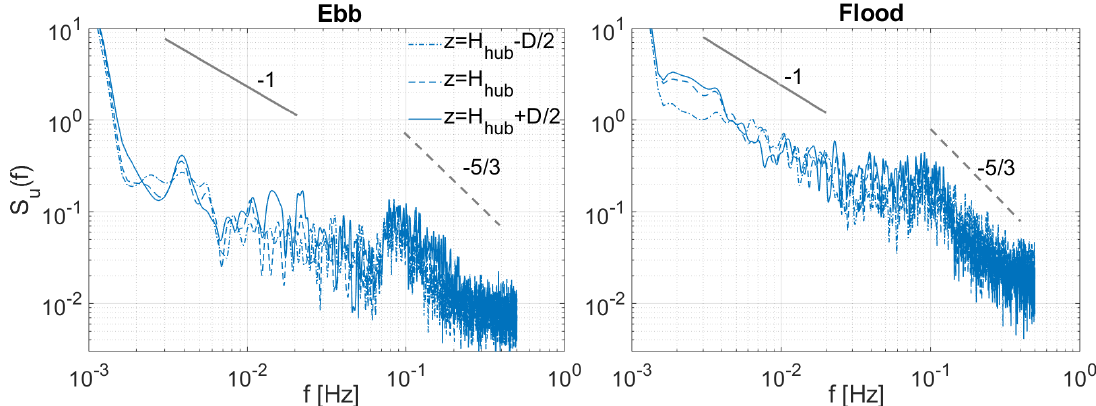
Figure 9. Power spectral distribution of streamwise velocity during ebb ( left ) and flood ( right )